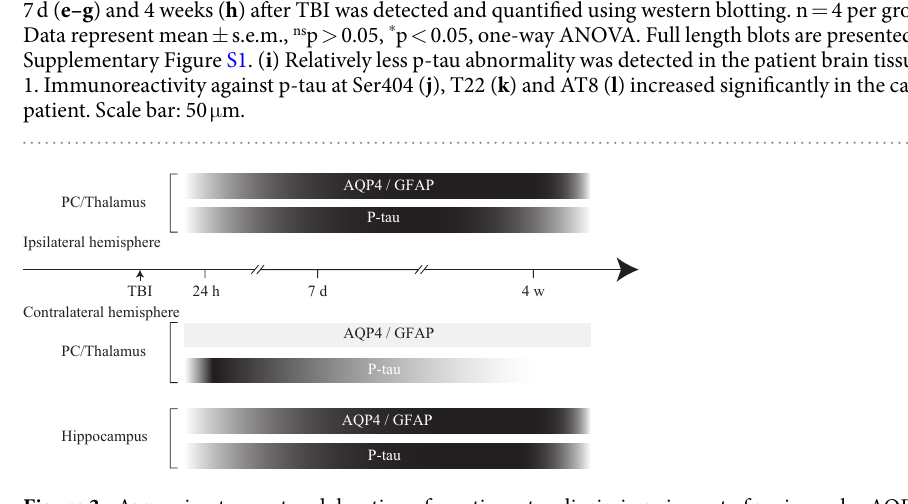
Figure 3. Approximate onset and duration of reactive astrogliosis, impairment of perivascular AQP4 polarity and accumulation of p-tau in different brain regions following TBI. The horizontal bars intend to illustrate the approximate onset and extent of the changes in GFAP and p-tau immunoreactivities, and impairment of AQP4 polarity. The increase in shading intensity reflects an increased severity of these pathological